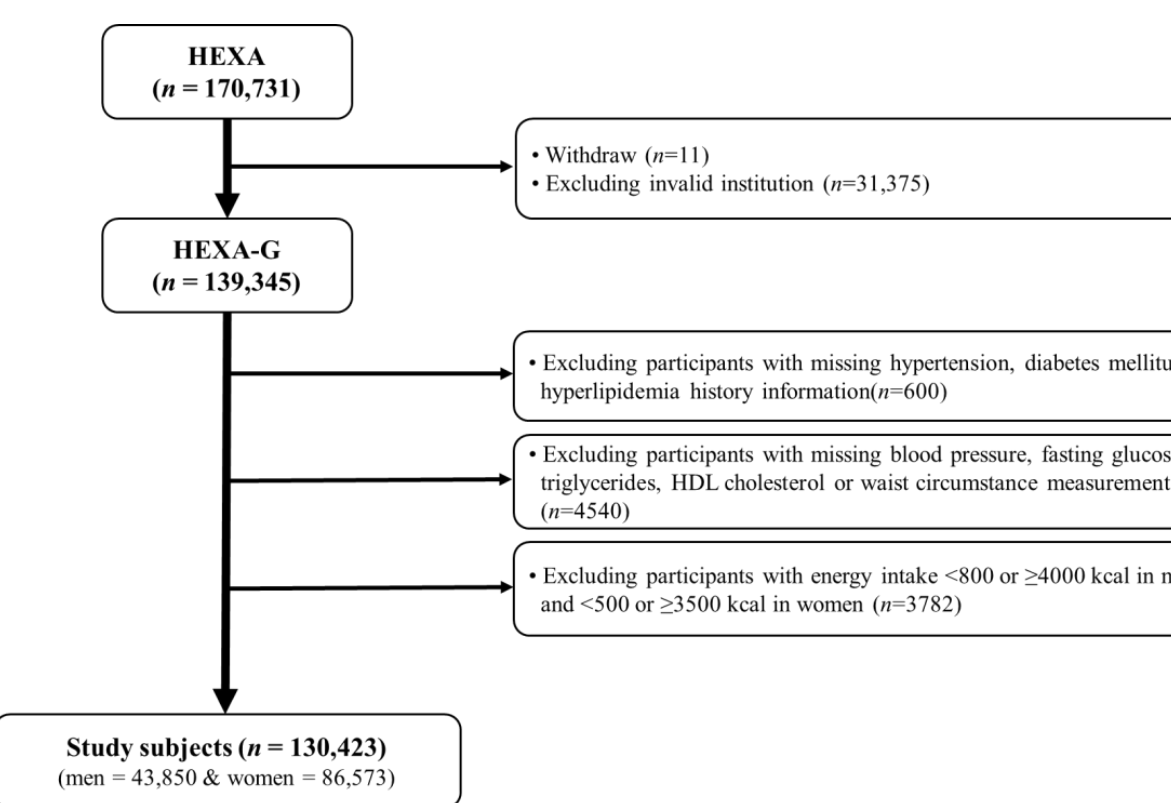
Figure 1. Flow diagram of analytical sample in this study using the health examinees (HEXA) cohort.